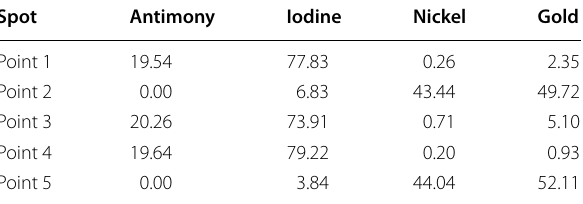
Table 4 Elemental distribution (atomic %) of the individual elements observed on a particular spot on (CH NH ) Sb I /NiO substrate shown in Fig. 4d 3 3 3 2 9